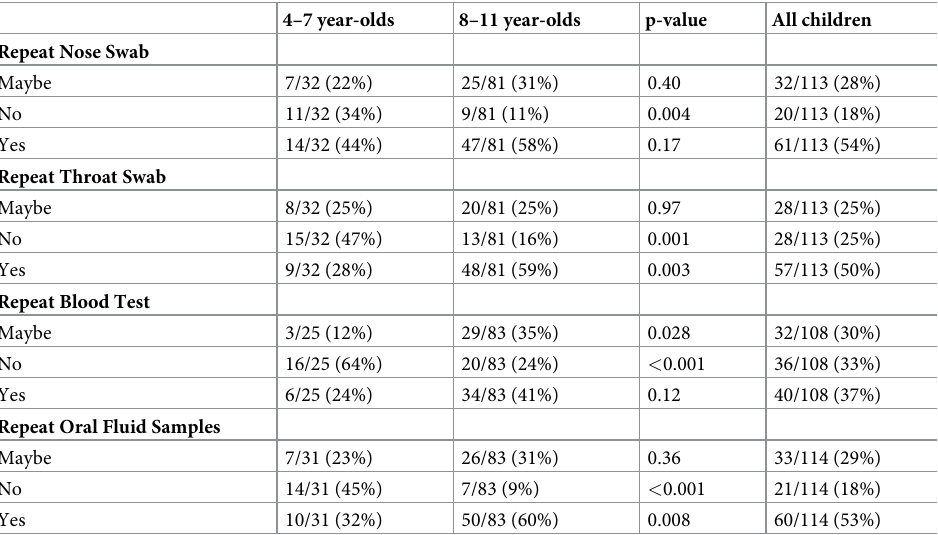
Table 2. Children’s responses when asked if they would have each individual test